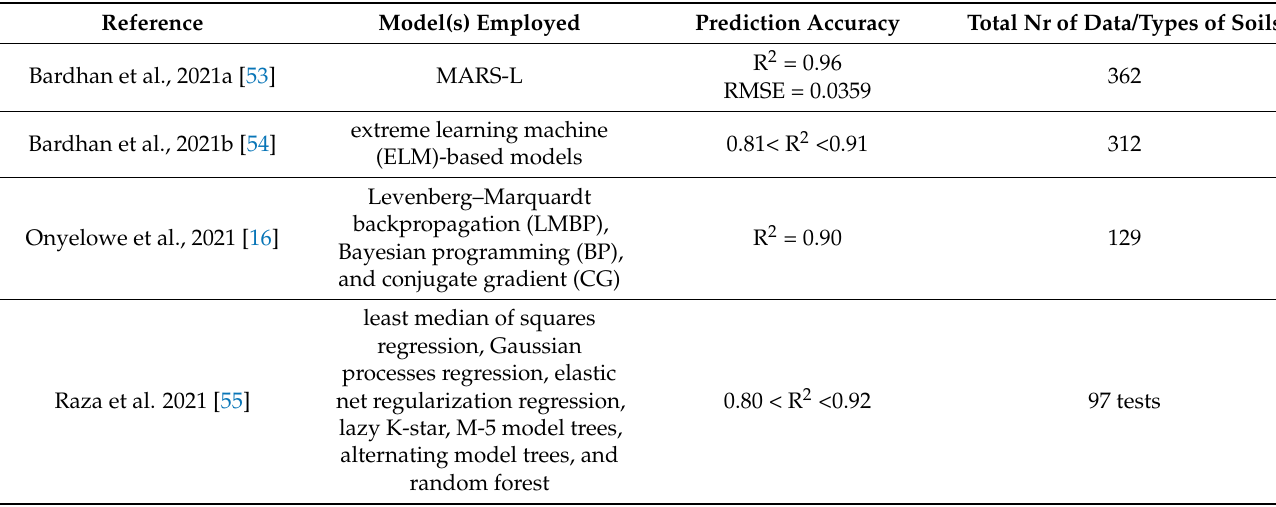
Table 1. Prediction accuracy of the soft computing models predicting the CBR of soil reported in the reviewed literature.